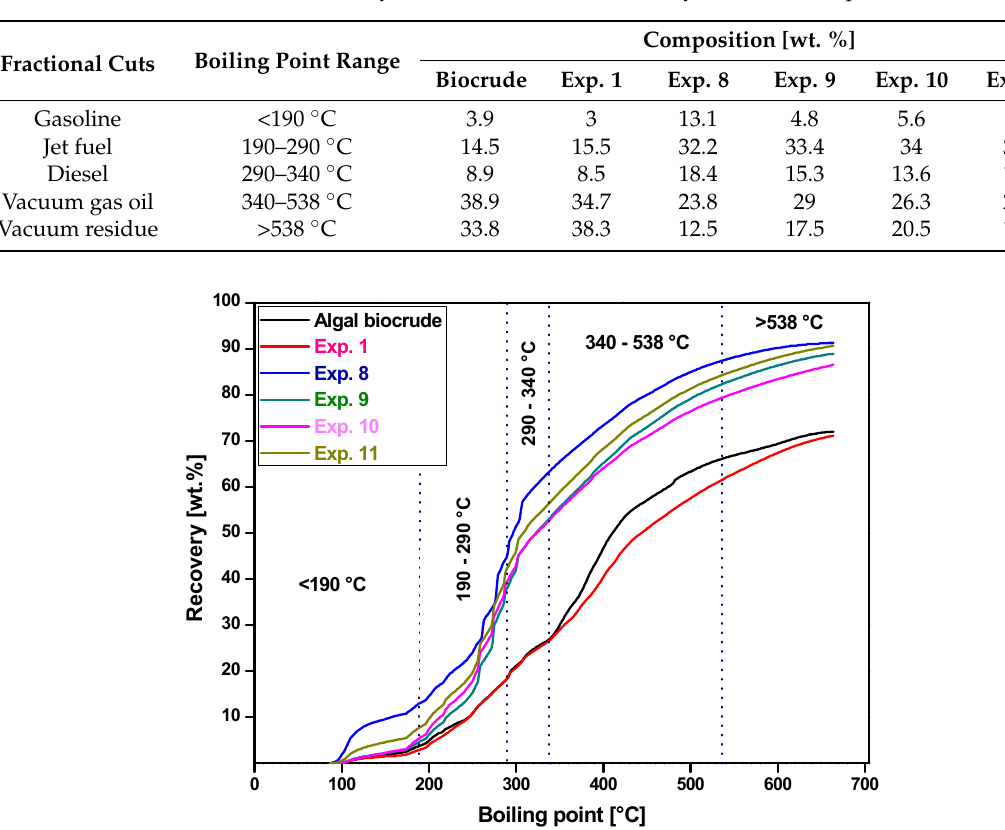
Figure 3. GC-MS chromatographs of ( a ) bio crude and ( b ) Experiment 8 at 350 °C.